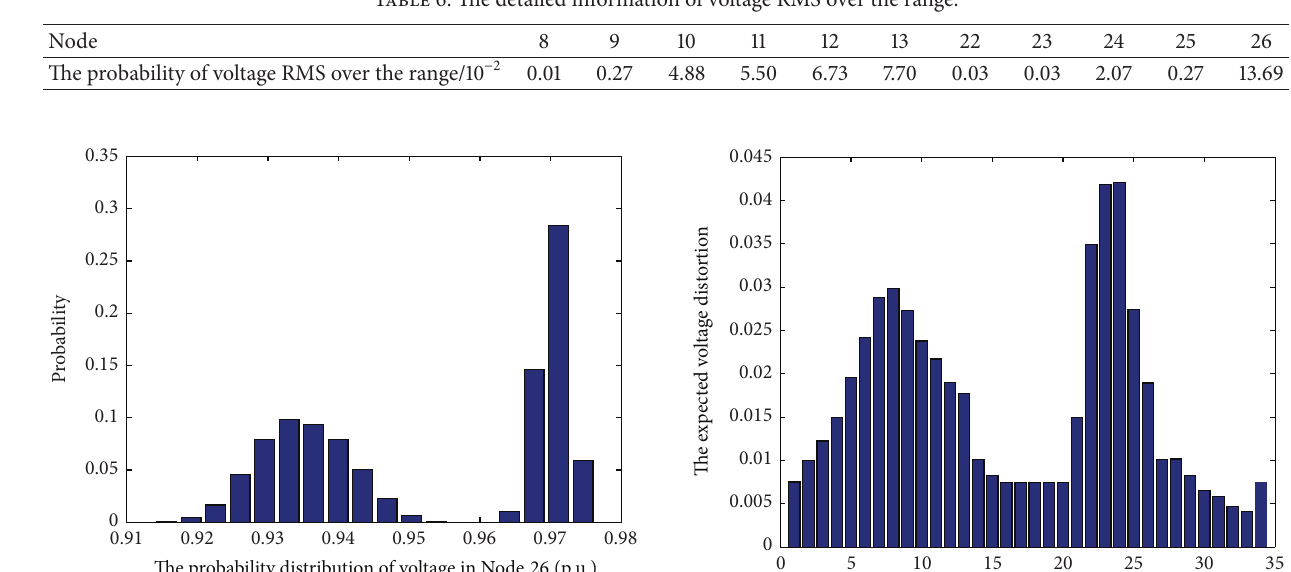
Table 6: The detailed information of voltage RMS over the range.